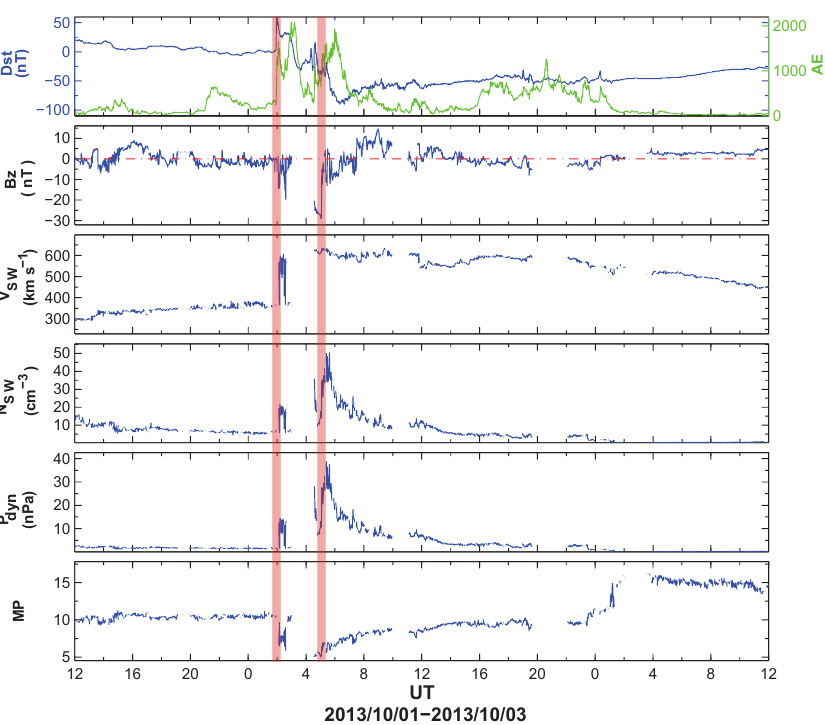
Figure 1. Time series of OMNIWeb geomagnetic indices and solar wind parameters for the 2-day interval between 12:00UT on 1 October and 12:00UT on 3 October, 2013. From top to bottom: Dst and AE, IMF B z , solar wind speed ( V sw ) , solar wind proton density ( N sw ) , solar wind dynamic pressure ( P dyn ) , and the magnetopause standoff distance modeled following Shue et al. (1997). The two vertical lines denote the start time of the two intense P dyn enhancements during the intense solar wind dynamic pressure